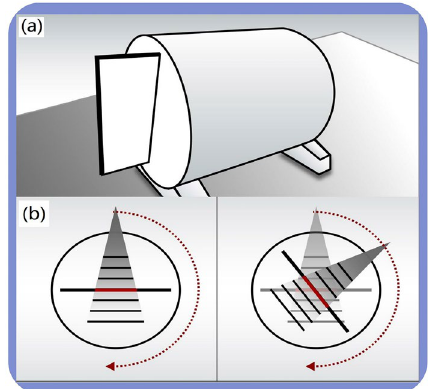
Figure 1. Schematic diagram of Octavius devices. ( a ) Octavius ion chamber detector array was inserted into the cylindrical phantom placed on the treatment couch; ( b ) The detector array always perpendicular to the beam axis measures plane dose at each control